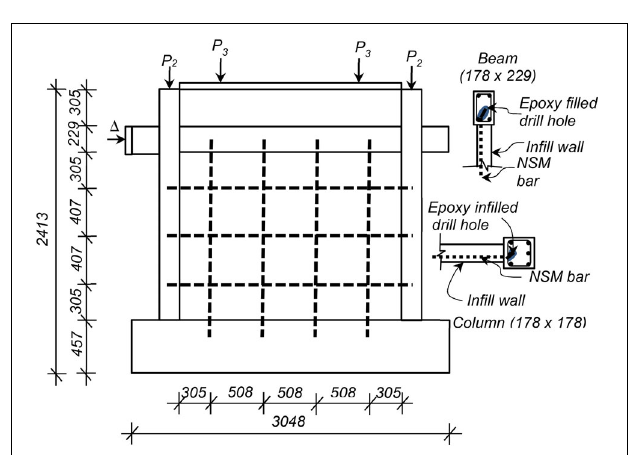
FIGURE 2 | Retrofitting details for one-bay frame retrofitted with three horizontal and four vertical bars. The non-retrofitted model represents Specimen 9 in Mehrabi et al. (1994). NSM reinforcing bars are shown in dashed lines. Arrows represent the load on columns and wall, respectively, which were applied during the testing. Delta ( (cid:49) ) represents a displacement controlled monotonic or cyclic loading. All dimensions in